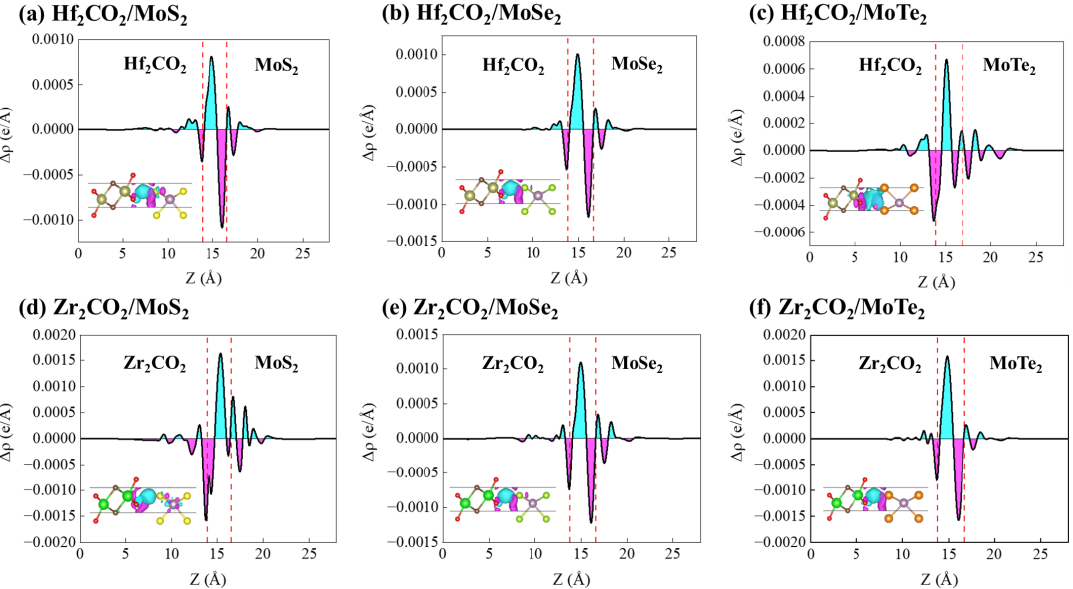
Figure 5. The 3D iso-surfaces and plane-averaged charge density differences along the z -direction for: ( a ) Hf 2 CO 2 /MoS 2 , ( b ) Hf 2 CO 2 /MoSe 2 , ( c ) Hf 2 CO 2 /MoTe 2 , ( d ) Zr 2 CO 2 /MoS 2 , ( e ) Zr 2 CO 2 /MoSe 2 , and ( f ) Zr 2 CO 2 /MoTe 2 heterostructures. The depletion and accumulation of electrons are represented by magenta and blue contours, respectively.